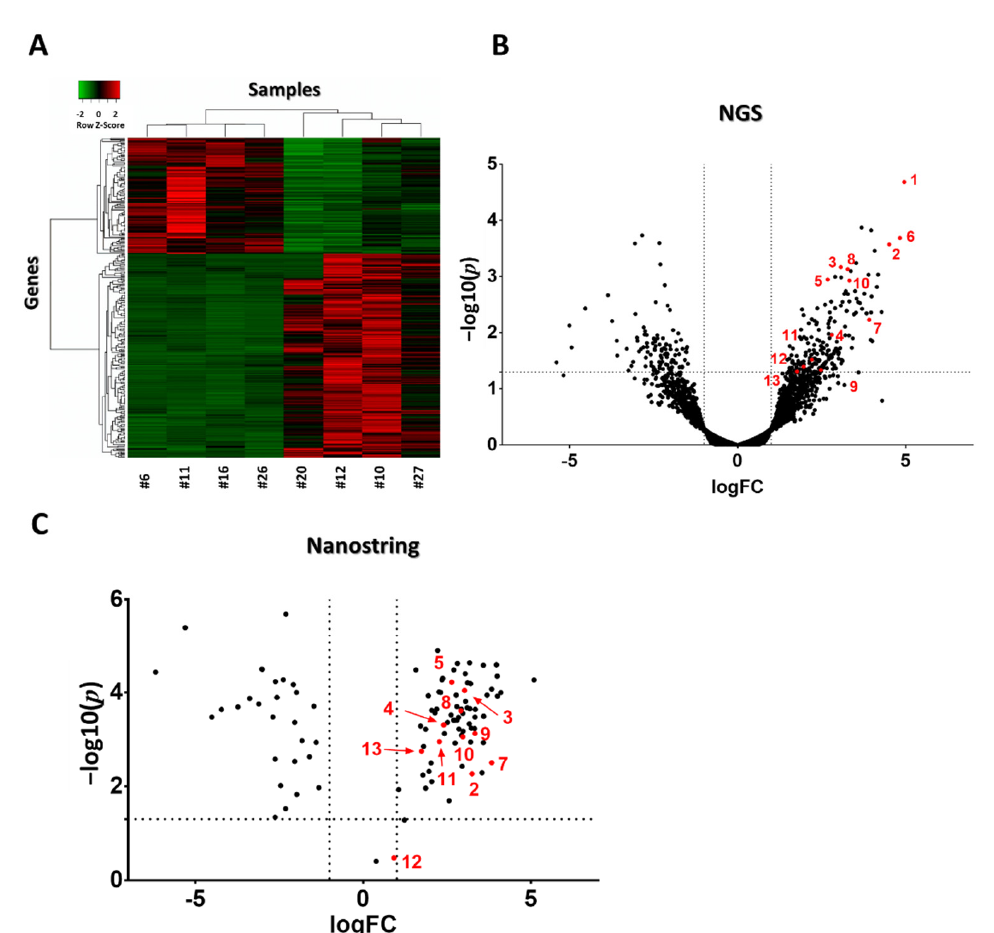
Figure 5. Heat map and volcano plot visualization of DE genes after three mEHT treatments. Heat map clusterization with dendograms (Kendall tau’s method, dendogram details: Figure S2) of differentially expressed (DE) genes according to the next generation sequencing (NGS) RNA seq data. Columns represent samples, rows represent genes. Red = upregulation, green = downregulation ( A ). Volcano plot of all genes according to the NGS RNA seq data ( B ). Volcano plot of DE genes from the Nanostring data ( C ). ( B , C ) − log10( p ) values plotted against fold changes (logFC). Vertical dotted line: logFC = 1, horizontal dotted line: − log10( p ) = 1.30103. n = 4–6/group. Red dots with numbers mark genes identified in Table 1. Cell line: 4T1, 3× treated. Table 1. Absolute mRNA Count of cellular stress response factors from the Nanostring data. Individual data of sham and mEHT group members and group averages. Bold letters : genes with highest mRNA absolute count and fold-change be- tween the two groups. Background values measured in negative, synthetic probe RNA counts were between 0–16. Cell line: 4T1, 3× treated. RNA Count